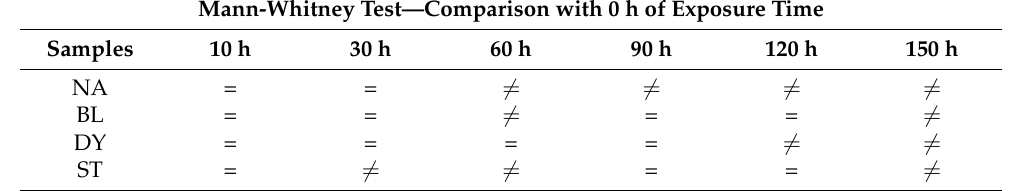
Table 4. Summary of Mann–Whitney statistical analysis comparing samples for each exposure time with samples not exposed to the Xenon arc